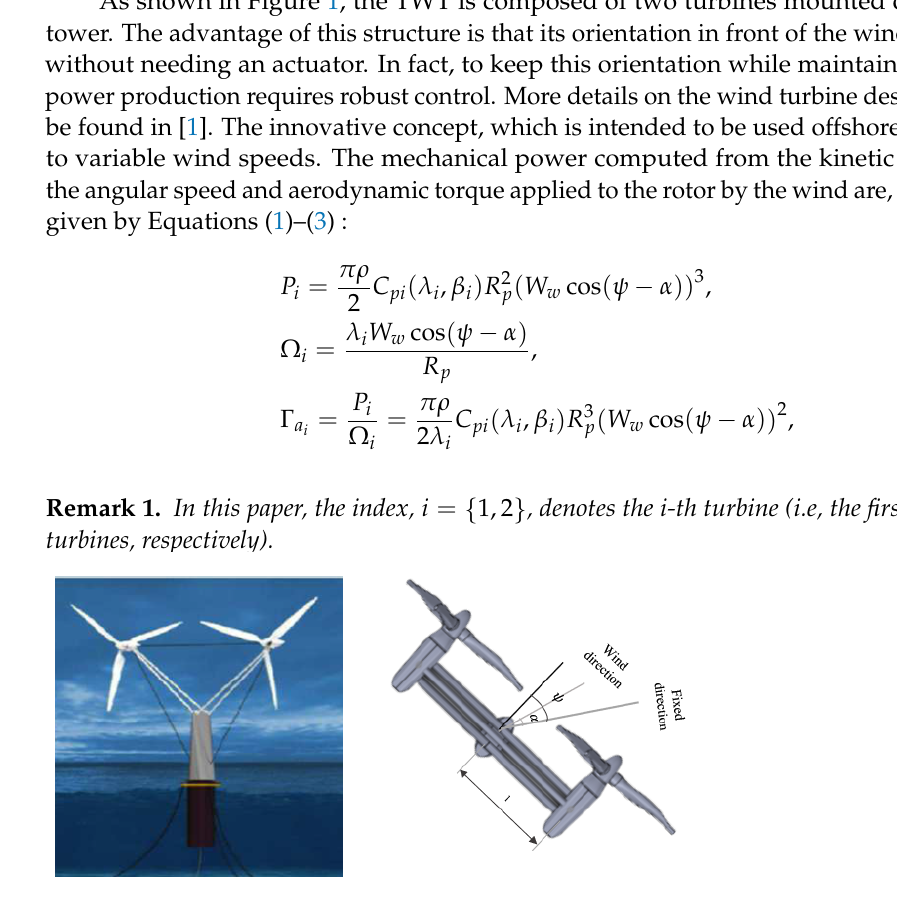
Figure 1. SEREO concept—face ( left ) and top ( right ) views. The angle α represents the angle between the wind direction and the fixed direction and the angle ψ is defined as the angle between the horizontal axis of structure and the fixed direction. C pi is the power coefficient [19], characterized by nonlinear functions depend on the pitch angle of blade β i and the tip speed ratio λ i , which is proportional to the rotor angular speed (see Equation